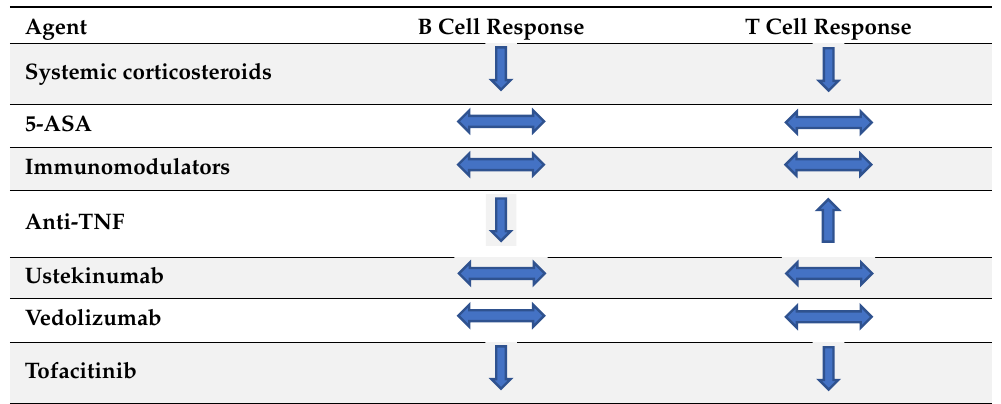
Table 2. Impact of medications on vaccine-induced B and T cell responses [2,20,22]. Agent